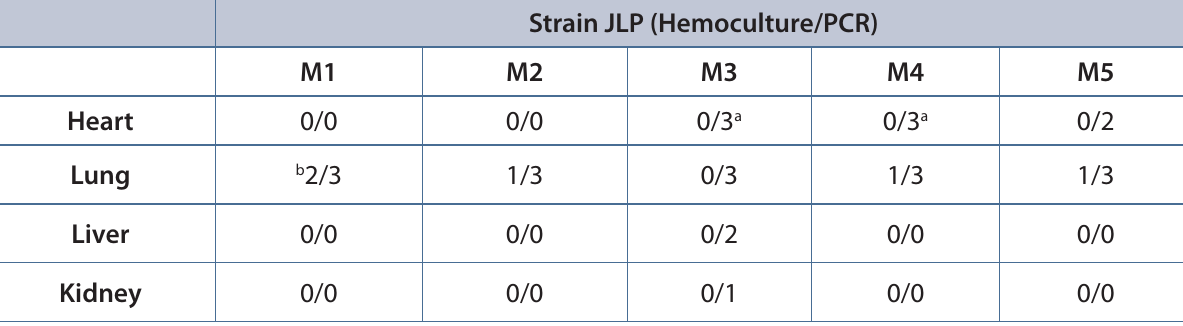
Table 3. Number of animals whose organs tested positive, by hemoculture or PCR analysis, following infection with T. cruzi strain JLP